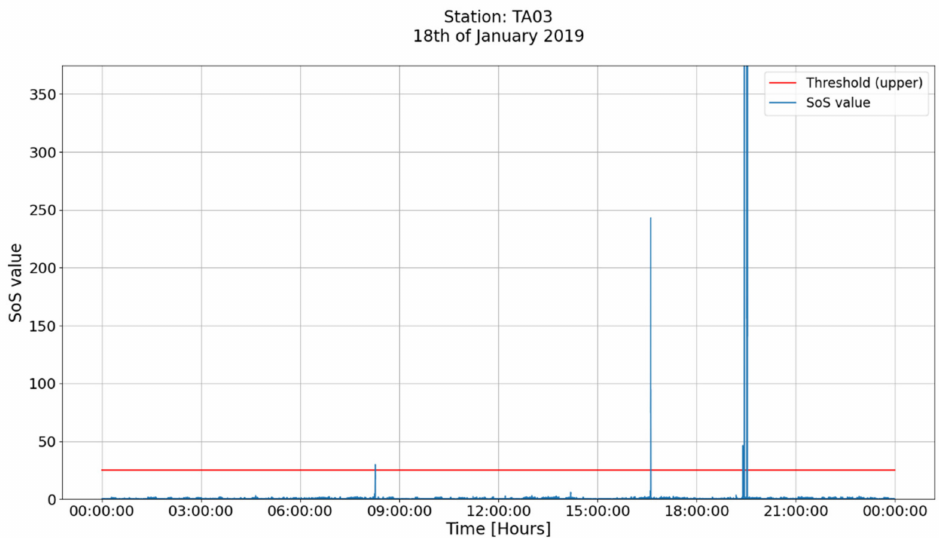
Figure 2. Sum-of-squares (SoS) values for TA03 on 18 January 2019. The red line marks the SoS detection threshold.